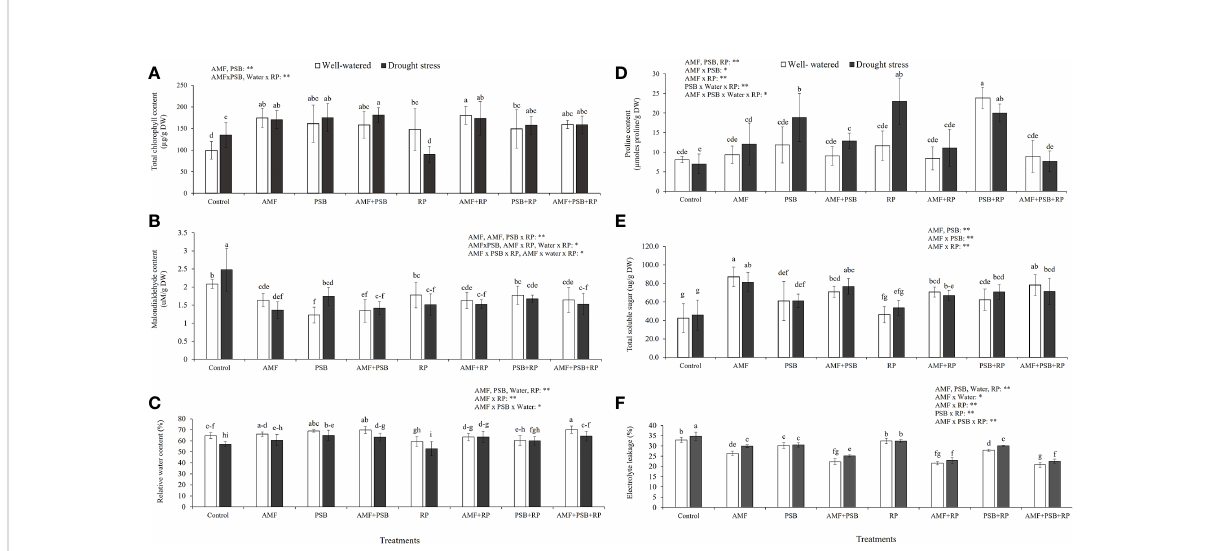
FIGURE 3 Physiological responses of sunchoke inoculated with AMF and PSB under well-watered (WW) and drought (DS) conditions evaluated at 60 DAT. (A) Total chlorophyll concentration, (B) Malondialdehyde concentration, (C) Relative water content (RWC), (D) Proline concentration, (E) Total soluble sugar concentration (TSS) and (F) Percentage of electrolyte leakage (%EL). Different letters indicate signi fi cant differences at P< 0.05 by LSD. Treatment means are the average of four replications. The signi fi cant effects of AMF, water, PSB, RP and their interactions are presented as the F value with test of signi fi cance (*P< 0.05; **P< 0.01) of four-way ANOVA. Non-signi fi cant factors are not